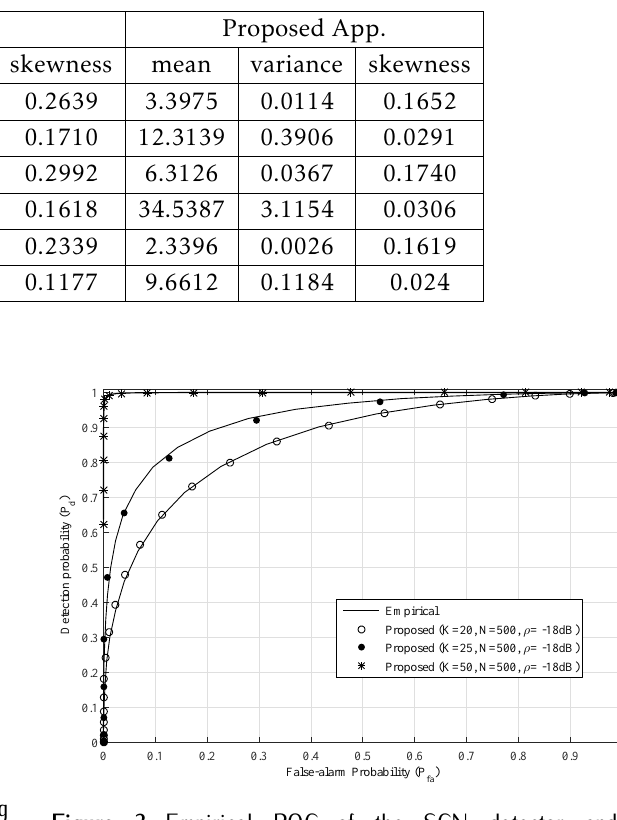
Figure 3. Empirical ROC of the SCN detector and its corresponding proposed approximation for different values of K with N = 500 and ρ = − 18 dB .